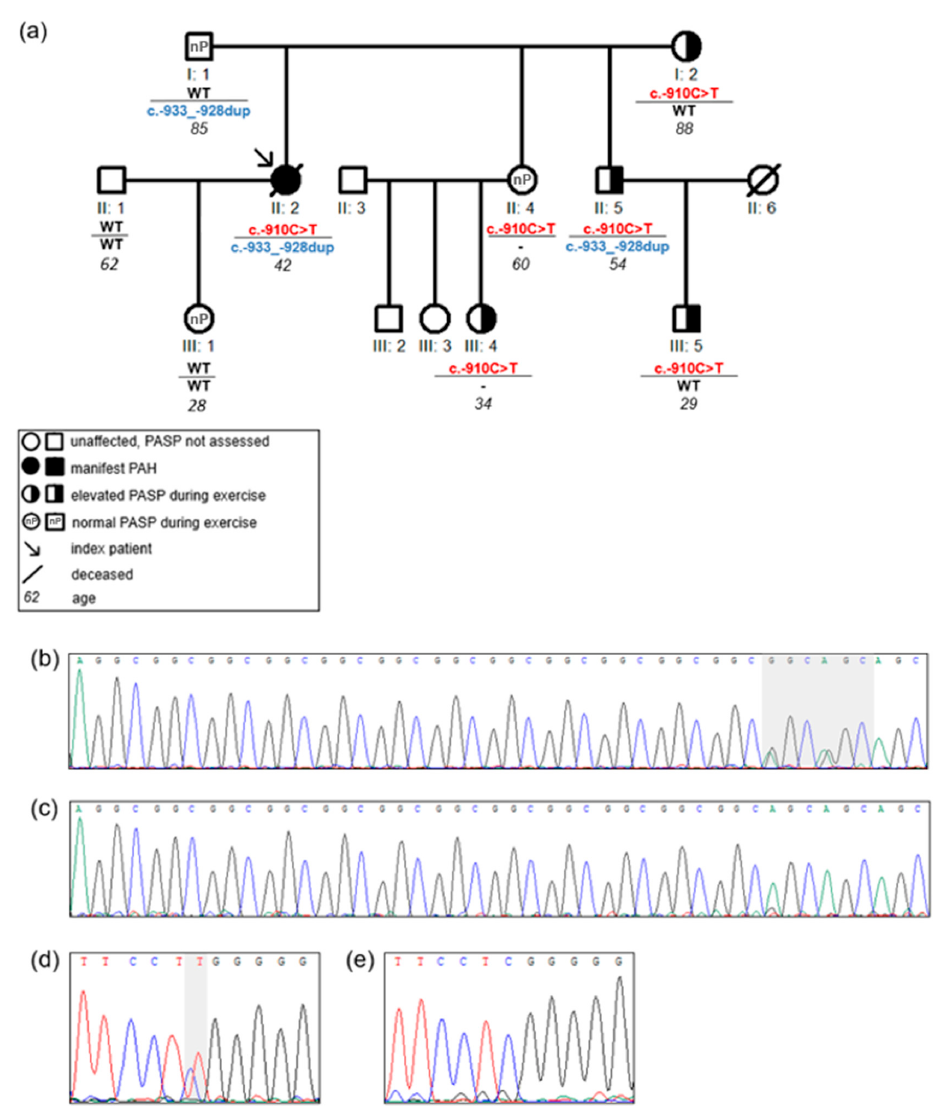
Figure 3. Pedigree of Family 1 with c.-910C>T and c.-933_-928dupGGCGGC in the 5 ′ UTR of BMPR2 gene: ( a ) the pedigree with BMPR2 5 ′ UTR variants c.-910C>T and c.-933_-928dupGGCGGC. Only the c.-910C>T variant is present in all family members with an elevated pulmonary arterial systolic pressure (PASP) during exercise. The horizontal line separates the two loci in BMPR2 5 ′ UTR c.-910C>T and c.-933_-928dupGGCGGC variants; c.-910C>T: BMPR2 c.-910C>T; c.-933_-928dup: BMPR2 c.-933_-928dupGGCGGC; WT: wild-type; -: not sequenced. Italic numbers represent the age of individuals; ( b ) sequencing analysis of the c.-933_-928dupGGCGGC shows the heterozygous G>A changes on the right side within the grey shaded area indicating a duplication of a 3 bp repeat; ( c ) c.-933_-928 wild-type sequence; ( d ) sequencing analysis of the heterozygous c.-910C > T variant within the grey shaded area; ( e ) c.-910 wild-type